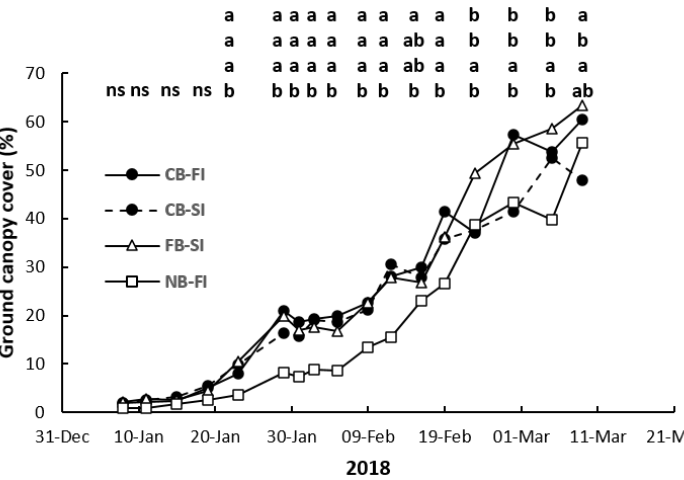
Figure 11. Average percentage of canopy ground cover (GCC) for the treatments assessed in experiment 4: conventional bed/furrow system with furrow irrigation (CB-FI), flat bed with sprinkler irrigation (FB-SI), conventional bed/furrow with sprinkler irrigation (CB-SI) and narrow beds with furrow irrigation (NB-FI). Different letters within a measurement date indicate statistically significant differences ( p < 0.05) between treatments. The order of the letters from top to bottom correspond with the order in which treatments are presented in the legend. “ns” denotes not statistically significant differences. Table 8. Average aboveground biomass measured at four stages of the crop in each combination of bed architecture and irrigation method tested in the 2017/18 dry growing season: (CB-FI) conven- tional bed/furrow system with furrow irrigation, (FB-SI) flat bed with sprinkler irrigation, (CB-SI) conventional bed/furrow with sprinkler irrigation and (NB-FI) narrow beds with furrow irrigation.